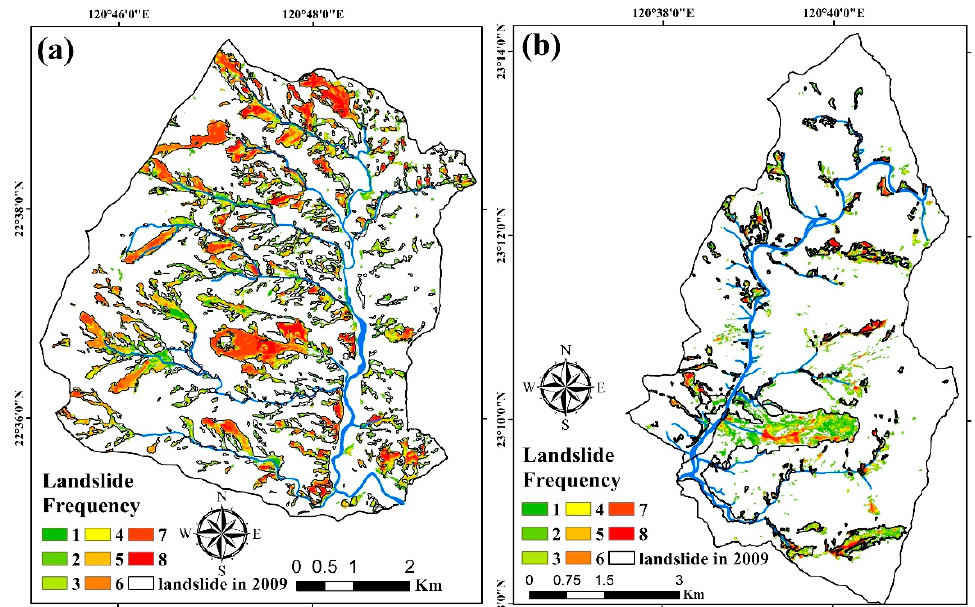
Figure 10. Distribution of landslide frequency from 2010 to 2017 in the Taimali upstream sub-watershed ( a ) and Kaoping upstream sub-watershed ( b ).